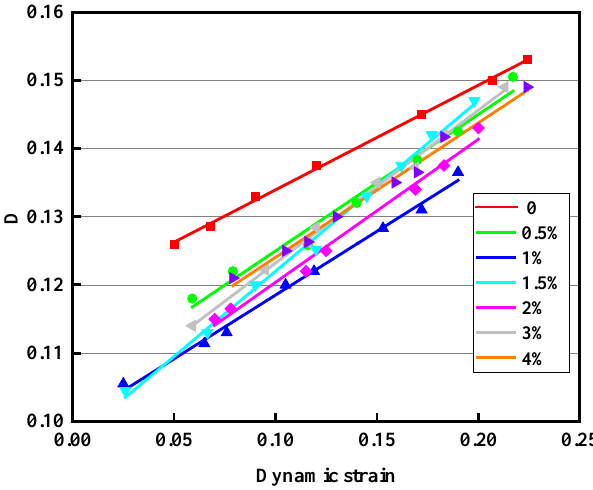
Figure 10. Variation of damping ratio with dynamic strain [47].